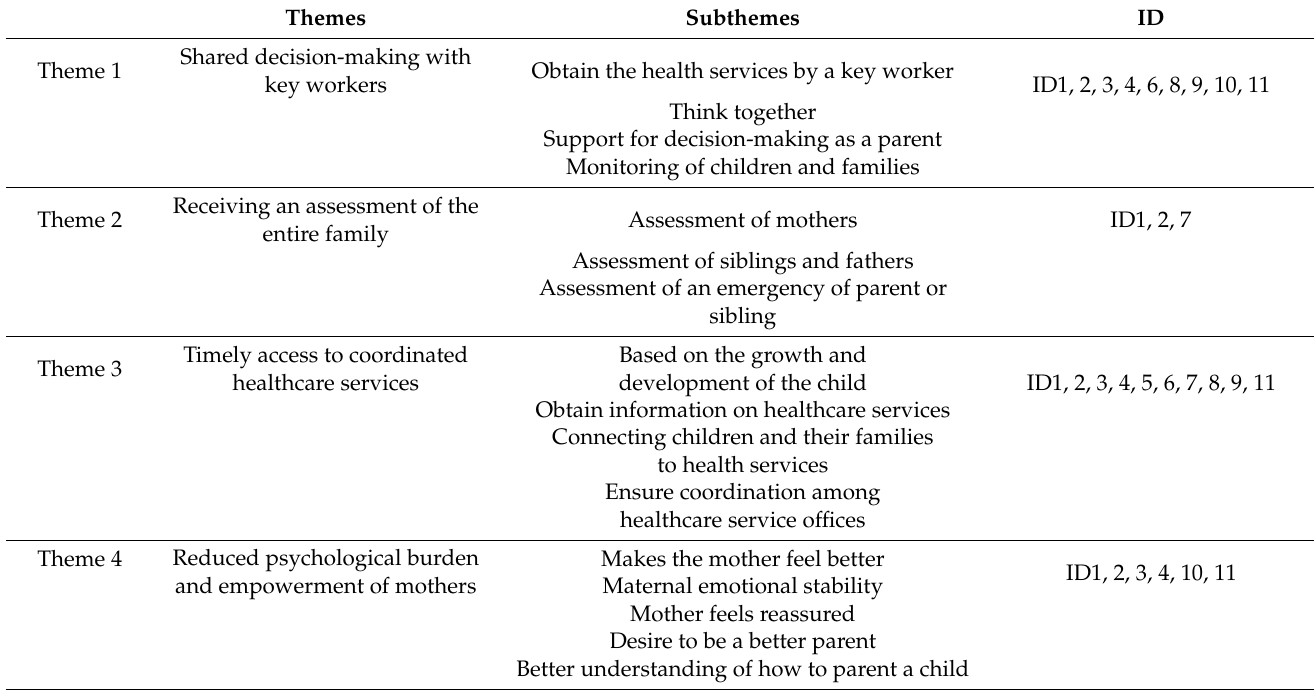
Table 2. Overview of themes and